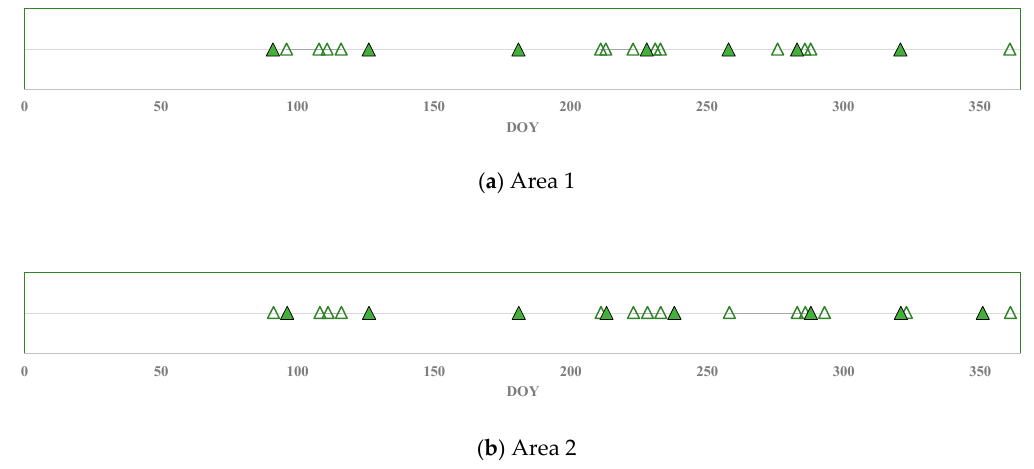
Figure 3. Images used for segmentation (solid triangles) and classification (all) for Areas 1 ( a ) and 2 ( b ). DOY = day of year.